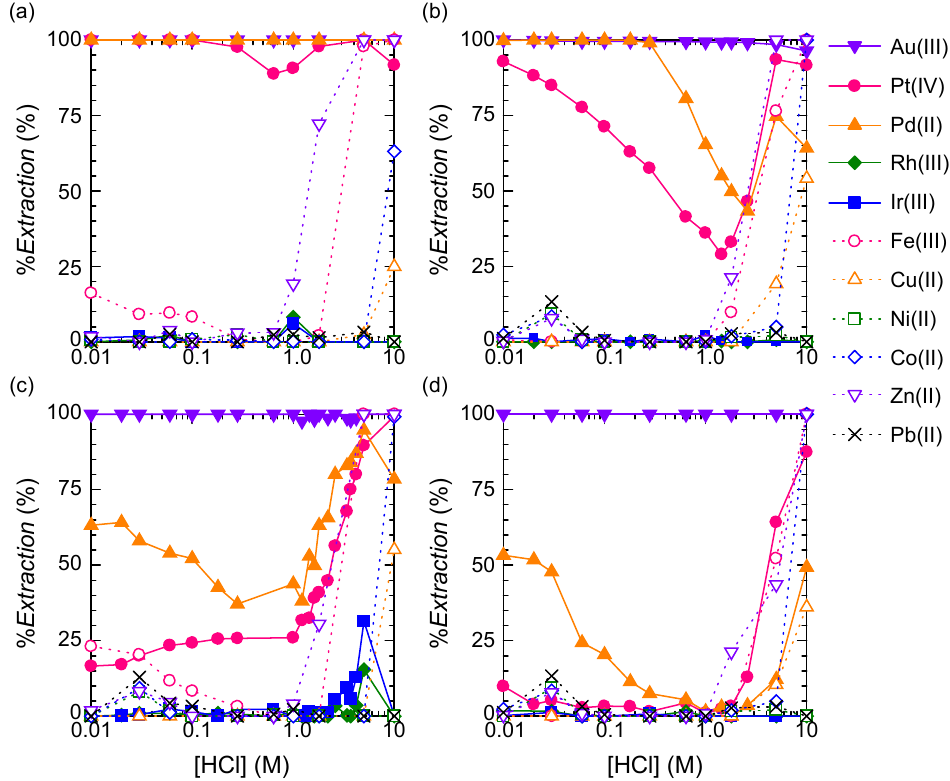
Figure 2. Effect of HCl concentration on the extraction percentage of metal ions by ( a ) MonoAA, ( b ) MonoOA, ( c ) MonoBU, and ( d ) BisAA. [Extractant] org,i = 1.0 M in chloroform, [Pt(IV), Pd(II), Rh(III), Ir(III), Fe(III), Cu(II), Ni(II), Co(II), Zn(II), Pb(II)] aq,i = 0.1 × 10 − 3 M each, [HCl] aq,i = 0.01–10